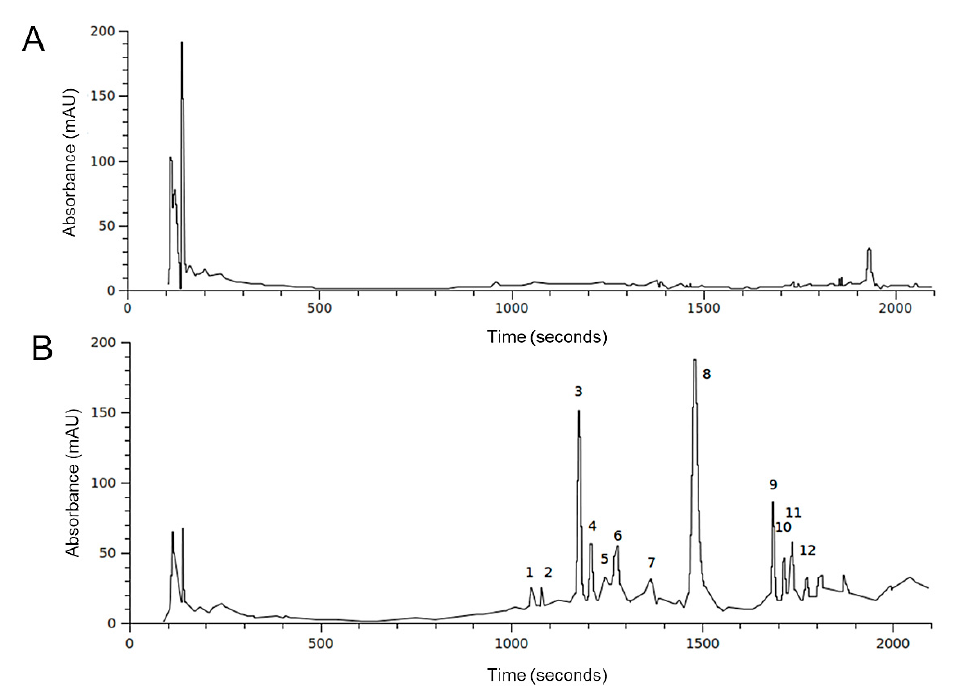
Figure 1. HPLC profiles at 280 nm of the H. incurva ethanol extracts. The peaks in HIE / m ( A ) and HIE / n ( B ) are labeled according to Table 2.